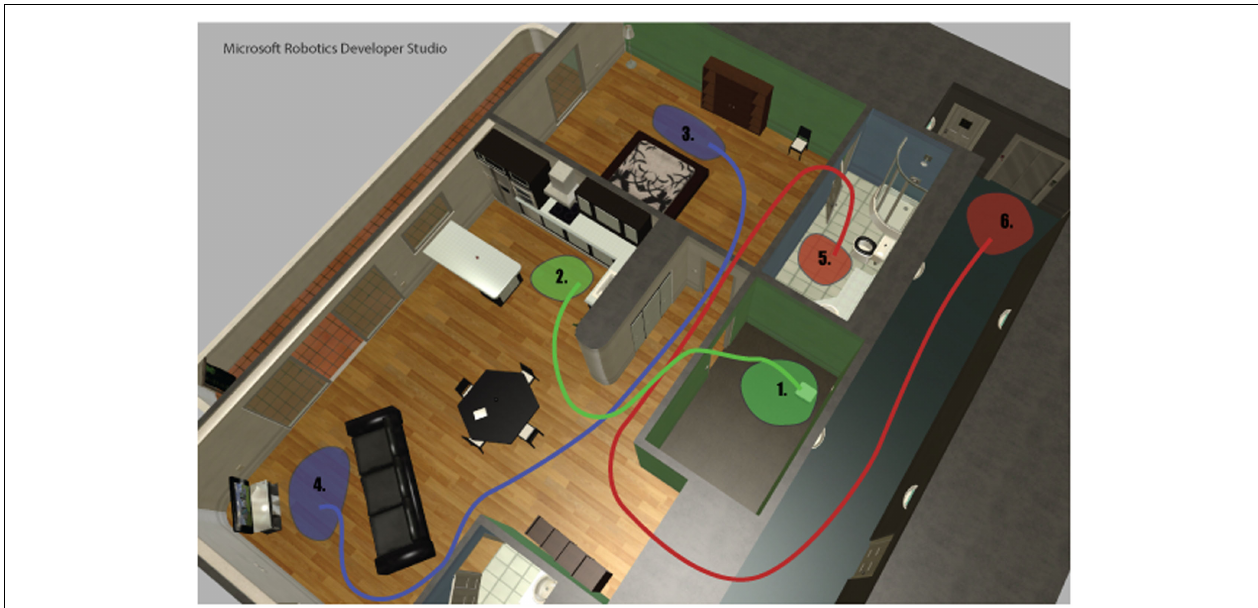
FIGURE 4 | Simulated apartment environment . Green, blue, and red lines indicate approximate paths from start (1, 3, and 5) to goal (2, 4, and 6) locations, for the three demonstrated behaviors, ToKitchen , ToTV , and GoOut . See text for details.